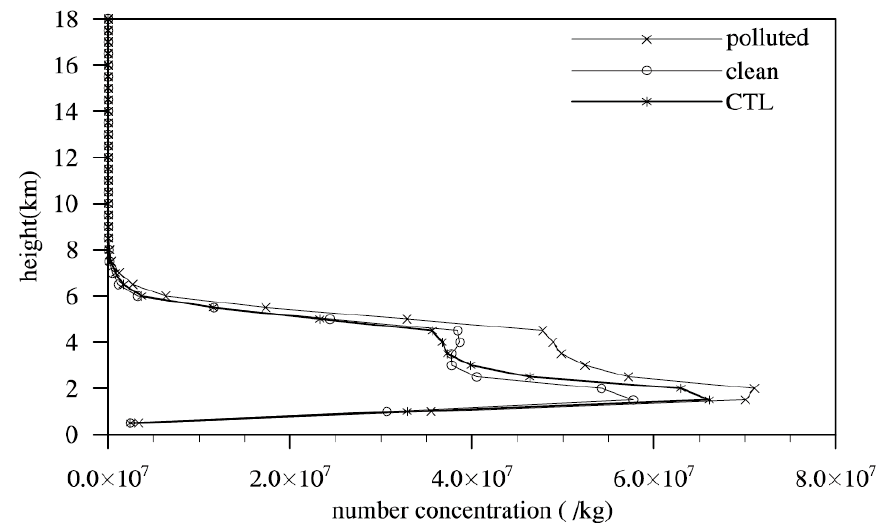
Figure 6. Time and area-average number concentration variation in cloud droplets with height in the Beijing area (kg − 1 ).